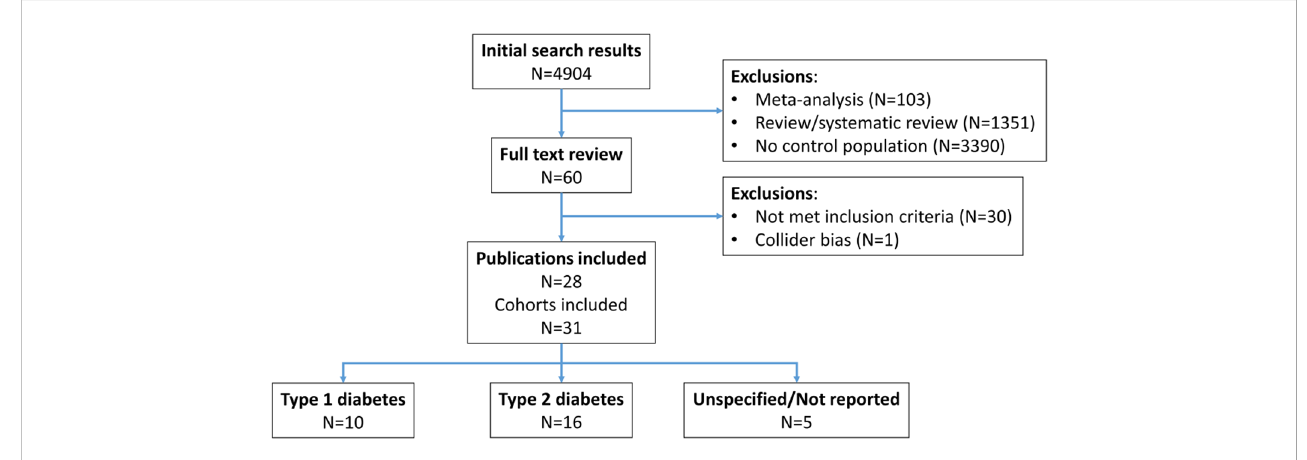
FIGURE 1 Flow chart of the selection of included